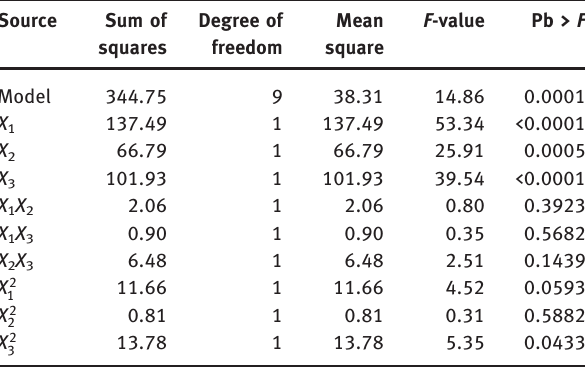
Table 4: Analysis of variance for the